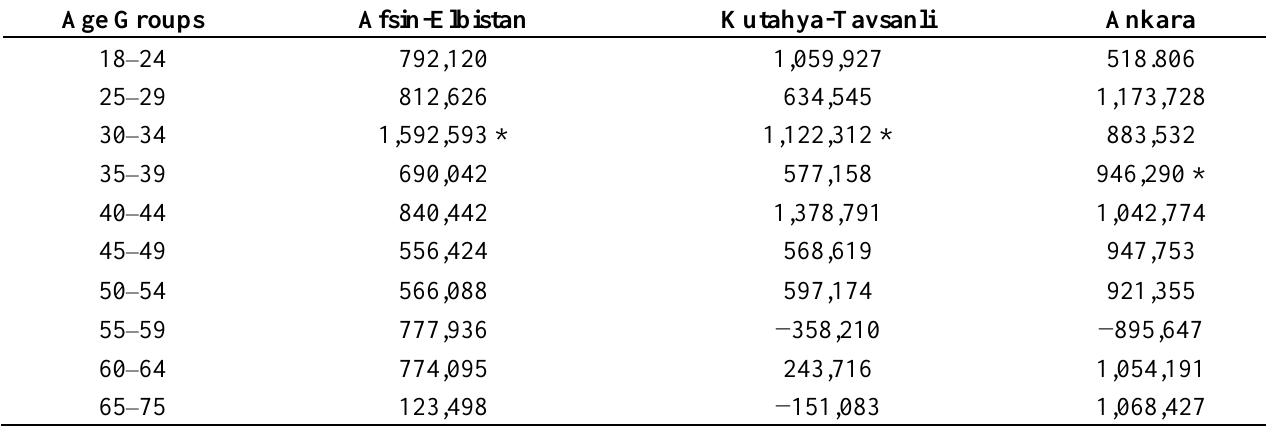
Table 12. Estimated VSL from Model 8 (in